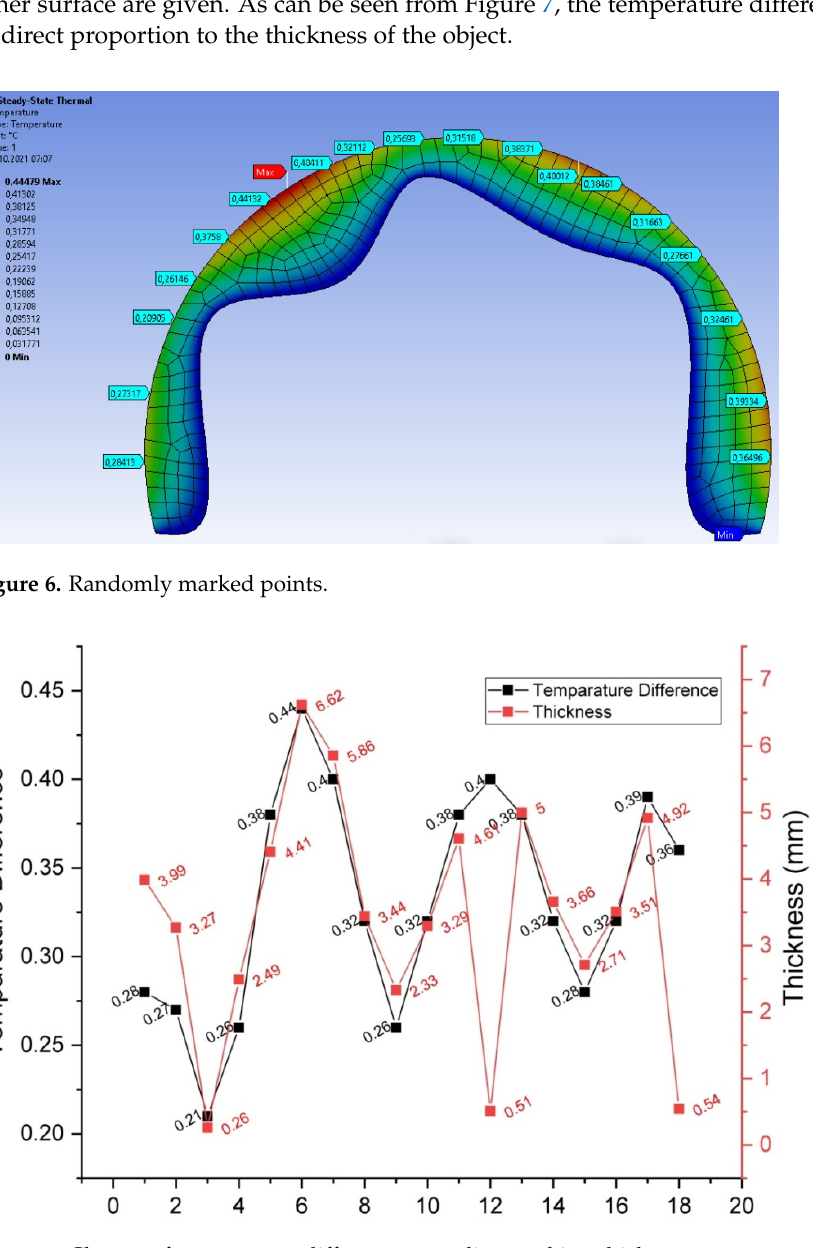
Figure 5. Temporal change of model heat transfer.